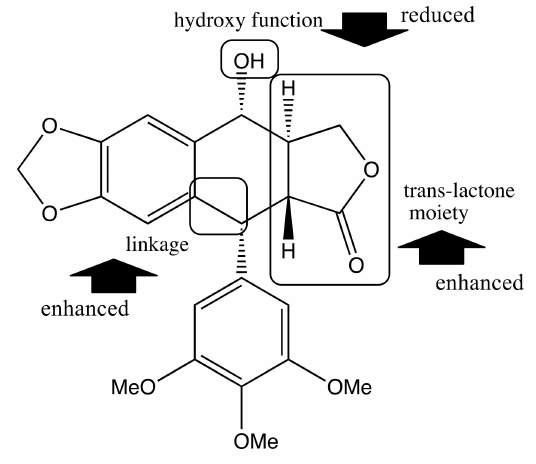
Figure 2. Structure–activity relationships of lignans. Several of the isolated terpenoid compounds inhibited the proliferation of cell lines. The presence of a double bond at position C-8 in compound 16 appeared to enhance its activity compared with compound 13 , which did not have a double bond at this position. Compared with compounds 15 and 16 , the presence of a ketone moiety at position C-7 enhanced the activity. Similarly, compared with compounds 18 , 19 , and 20 , the substituents (OH and ketone) influenced their activities (Figure 3).